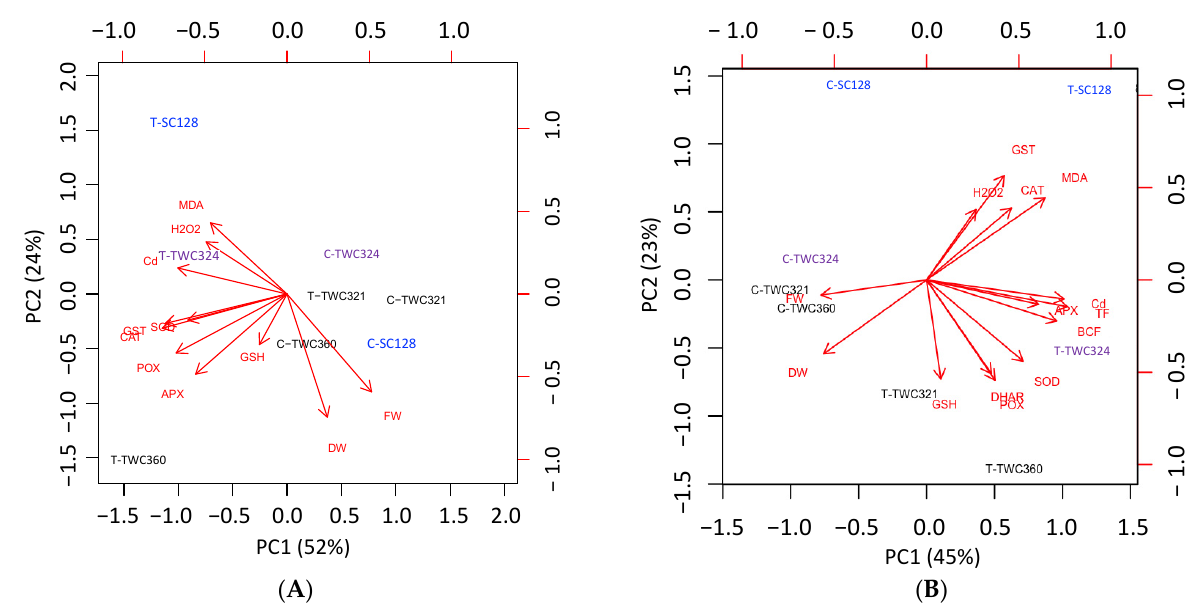
Figure 5. Principal component analysis (PCA) representing the contribution of biochemical parameters of ( A ) shoot and ( B ) root of maize tolerant (TWC321, TWC360) and sensitive (SC324, SC128) cultivars.